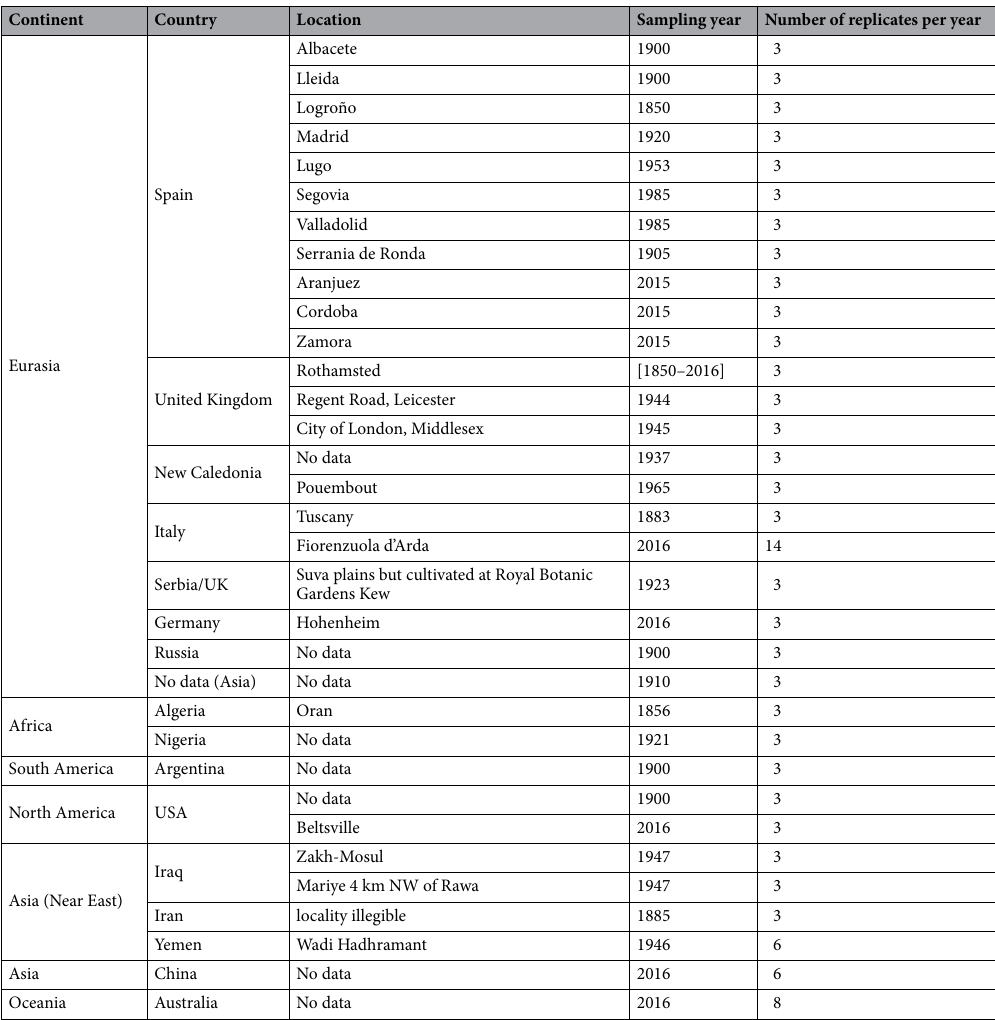
Table 1. Geographic origin and sampling year of archived wheat grain